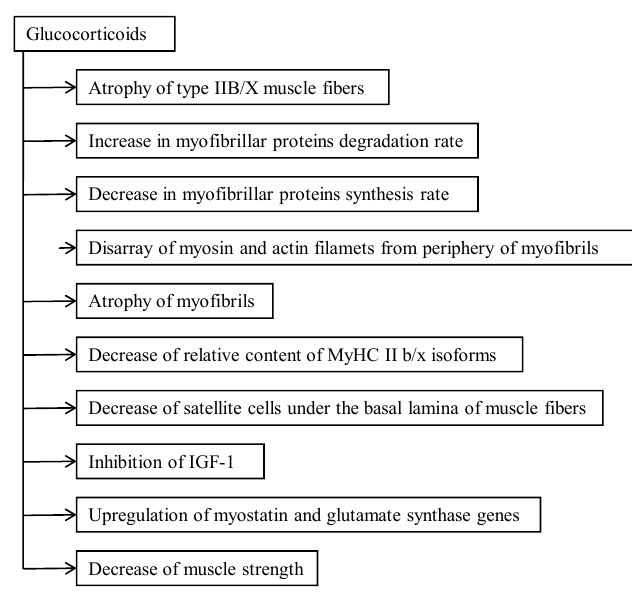
Figure 1. Effect of glucocorticoids on skeletal muscle.